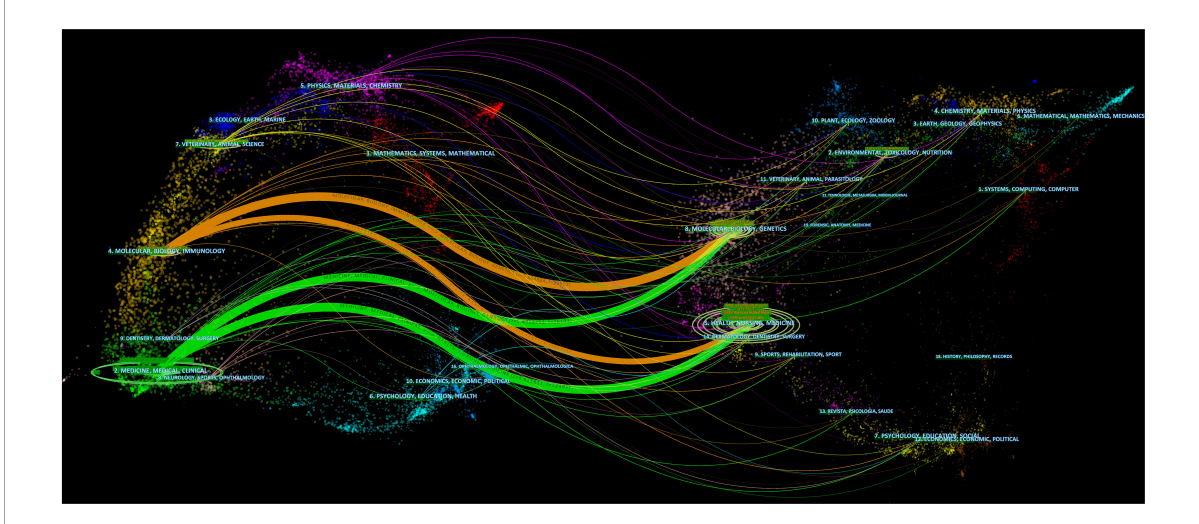
FIGURE5 The dual-map overlay of journals in the field of Helicobacter pylori -related gastric ulcer (GU). Citing journals appear on the left, cited journals appear on the right, and citation relationships are represented by colored paths.